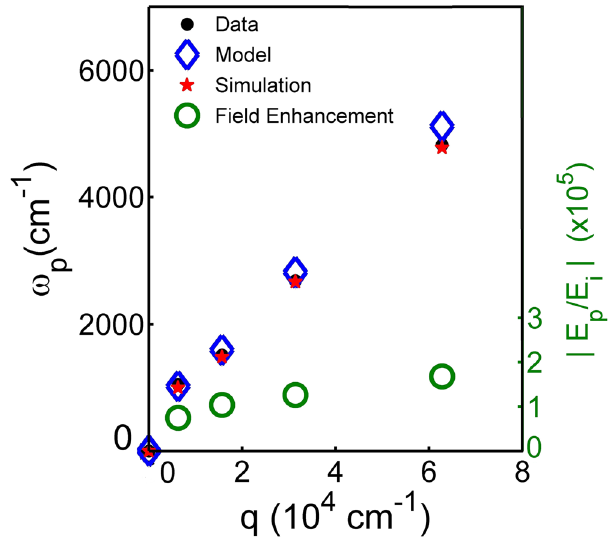
Fig. 4 Plasmon dispersion curves. Black points correspond to experimental plasmon frequencies, red stars to COMSOL simulation and blue diamonds to the model (Eq. (3) main text). Experimental, simulation and modeling dispersion well coincide at each wavevectors here measured.In the right axis the fi eld enhancement factor FE = | E p / E i | where E p is the electric fi eld at the plasmonic resonance and E i the incident fi eld, is plotted vs . the experimental wavevectors q. The strong fi eld enhancement suggests a SEIRA device applications for PdCoO 2 -based ribbon arrays 7